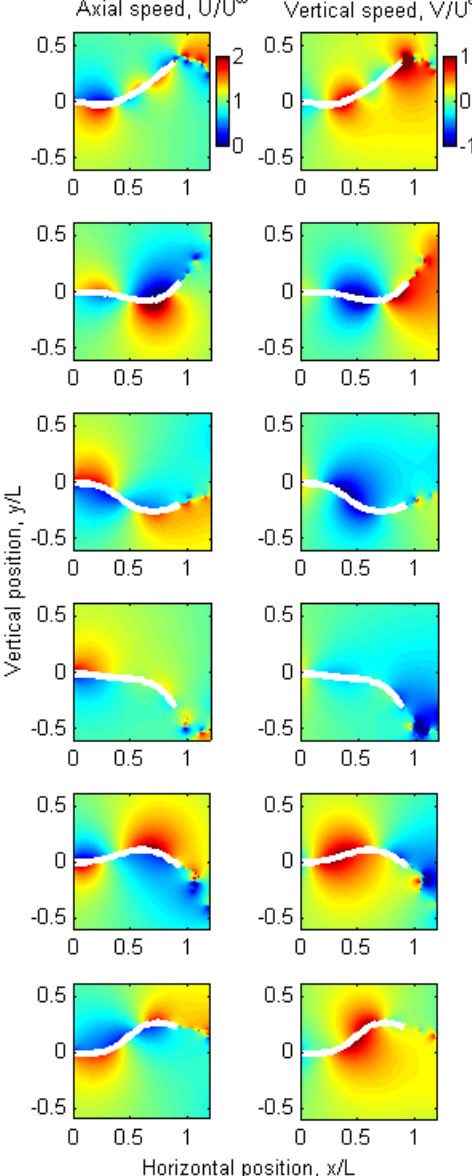
Fig. 10. Horizontal and vertical flow speed around the membrane at instants every 6 th of an undulation cycle.